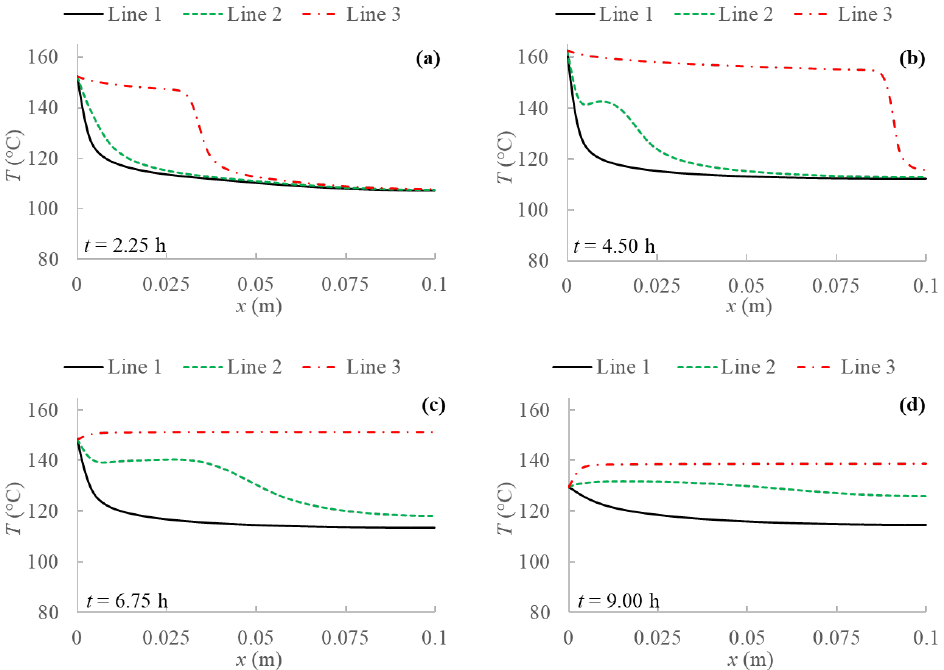
Figure 7. Temperature profiles for 2D model with natural convection and BC 3 evaluated at three different PCM transversal sections: Line 1 ( y = 0 m); Line 2 ( y = 0.05 m); Line 3 ( y = 0.1 m), and at different evaluation times: ( a ) after 2.25 h; ( b ) after 4.50 h; ( c ) after 6.75 h; ( d ) after 9.00 h from the simulation beginning respectively.